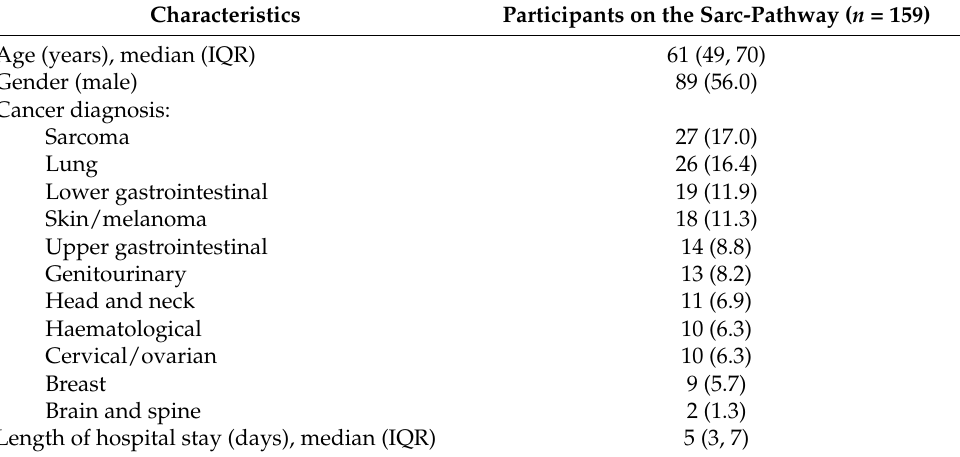
Table 2. Demographic and clinical characteristics of participants who consented to care on the